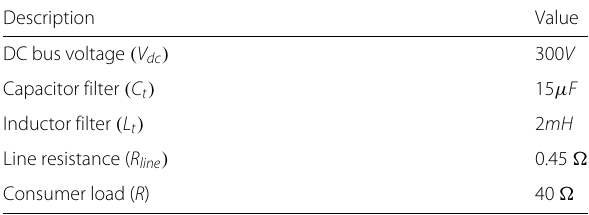
Table 1 Parameter values for single phase microgrid Description